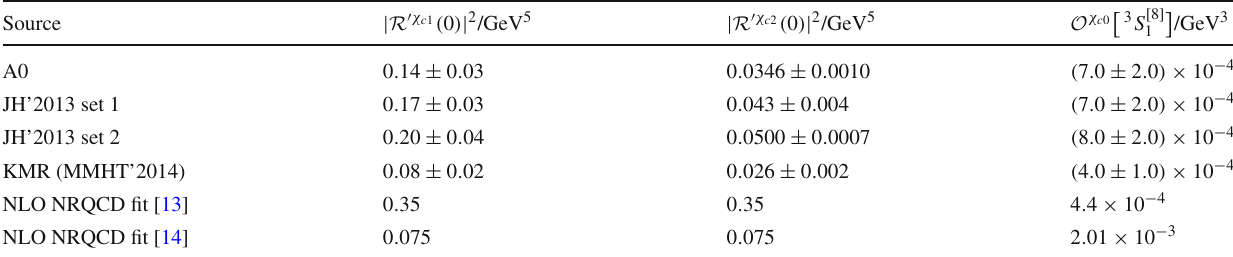
Table 1 The fitted values of LDMEs and CS wave functions at the origin (divided by the 2 J + 1 factor) for χ cJ mesons. The color-octet LDMEs are assumed to obey HQSS (“fit I” scenario). The results obtained in the NLO NRQCD fits [13,14] are shown for comparison